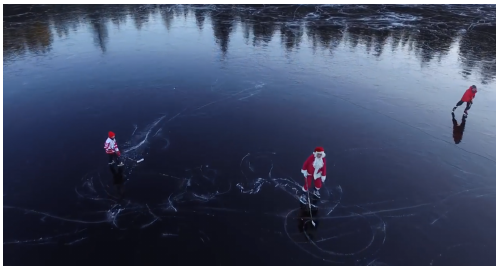
Figure 2. Input frame.